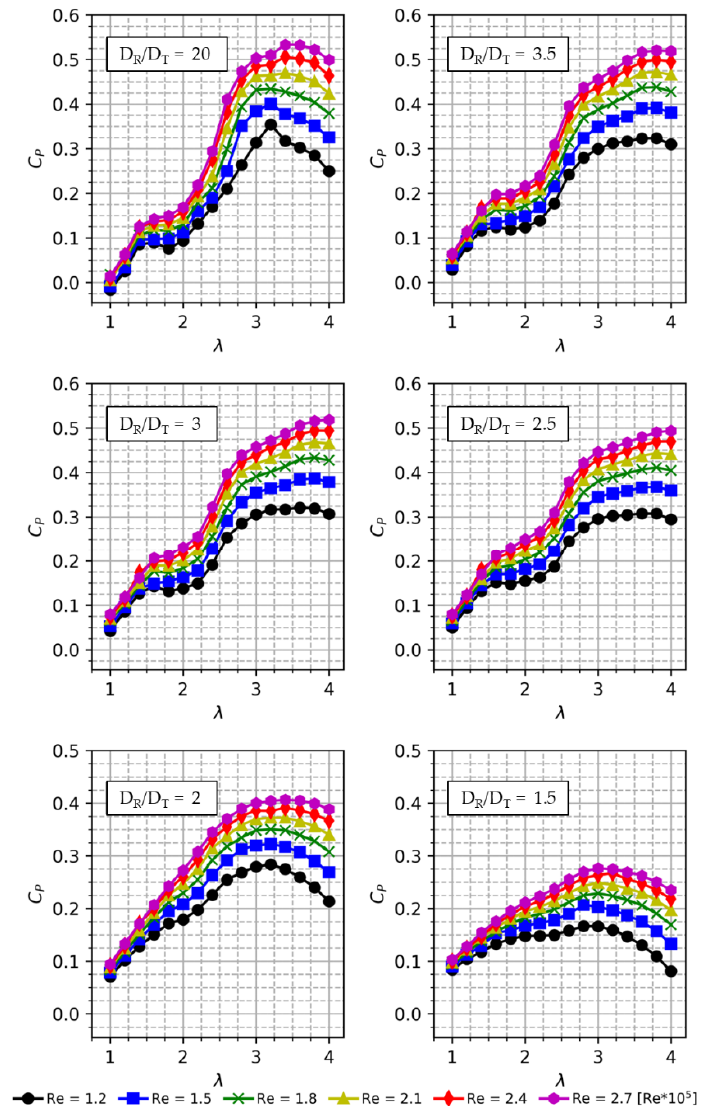
ff erent D / D R T